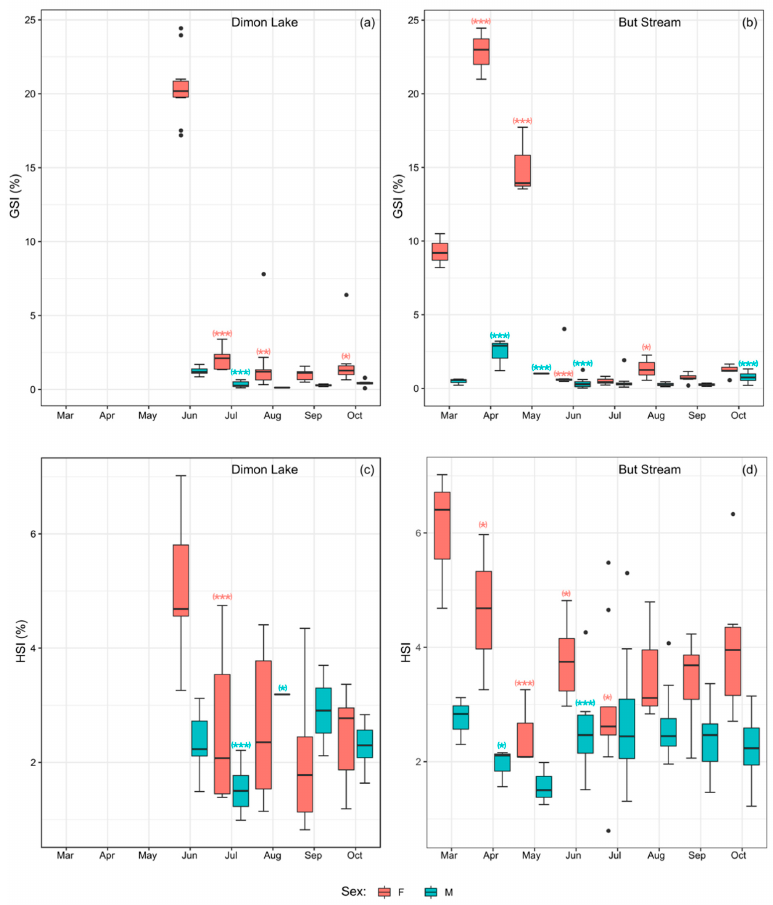
Figure 3. Trends in the gonadosomatic index of specimens from Dimon Lake ( a ) and But Stream ( b ) and trends in the hepatosomatic index in specimens from Dimon Lake ( c ) and But Stream ( d ) ( n = 20 per sample). Asterisks (* = p -level < 0.05; ** = p -level < 0.02; *** = p -level < 0.001; red for female and blue for males) indicate significant differences with the previous monthly values.